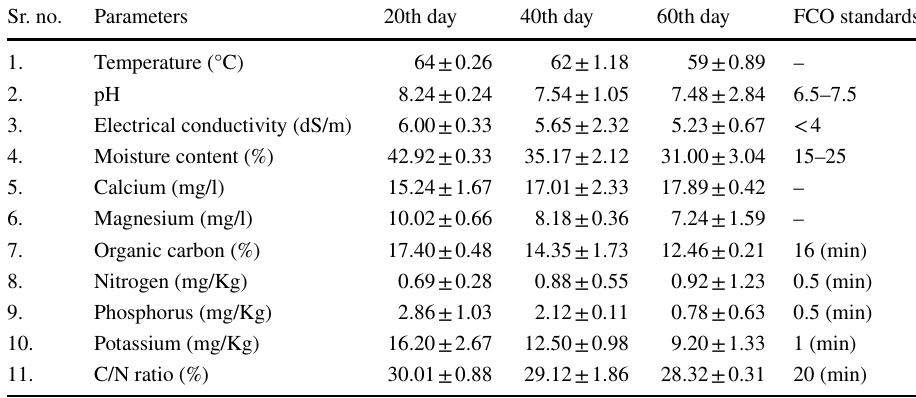
characterization of compost in Mandi